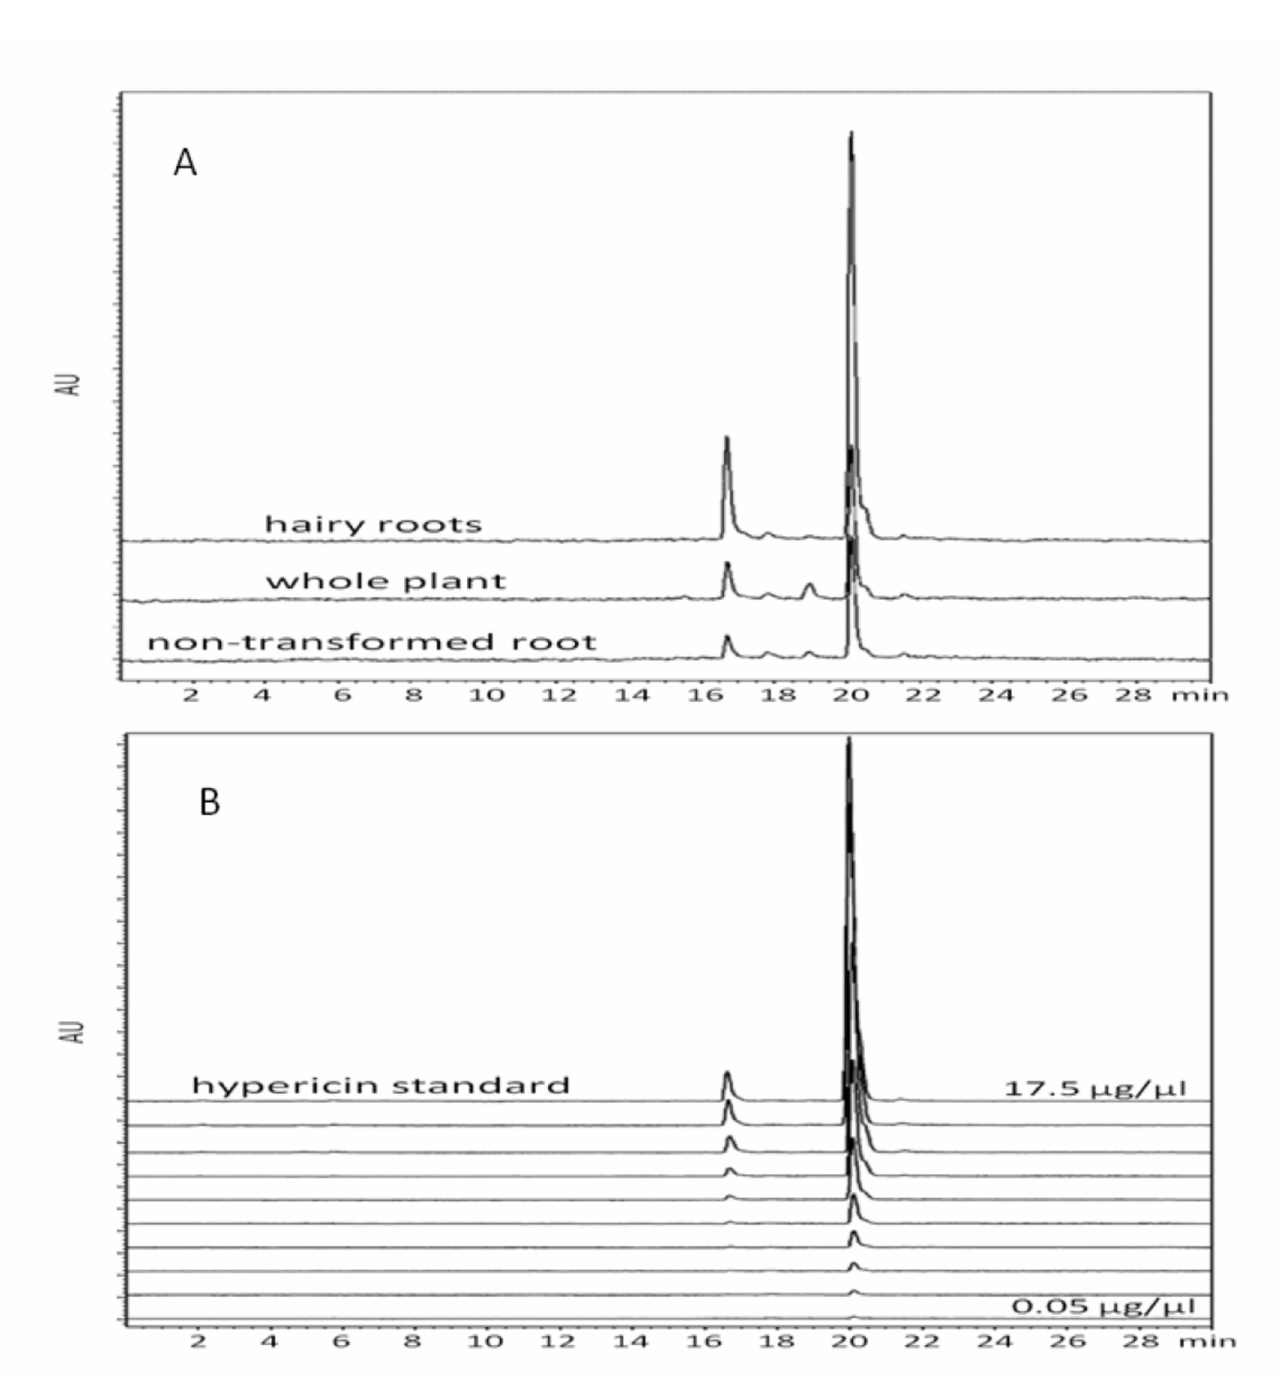
FIGURE 8 - HPLC detection of hypericin in H. sinaicum hairy roots and plant. Hypericin characteristic peaks in chromatograms for samples of hairy roots and control, not transformed whole plant and its roots (A). Quantitative analysis of hypericin standard applied in the range 0.05-17.5 µg/µL